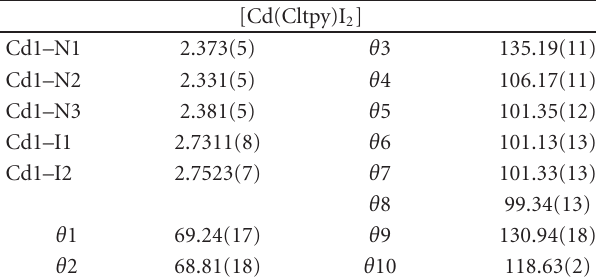
Figure 2: Molecular structure of [Cd(Cltpy)I 2 ] including the atom numbering scheme. All hydrogen atoms have been omitted for clarity.